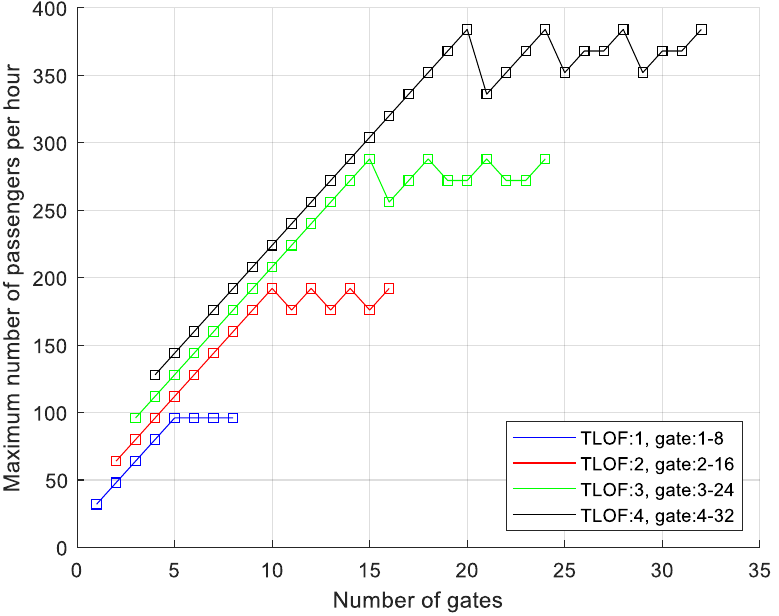
Figure 45. Maximum number of passengers per hour according to the TLOF pad and gate ratio.